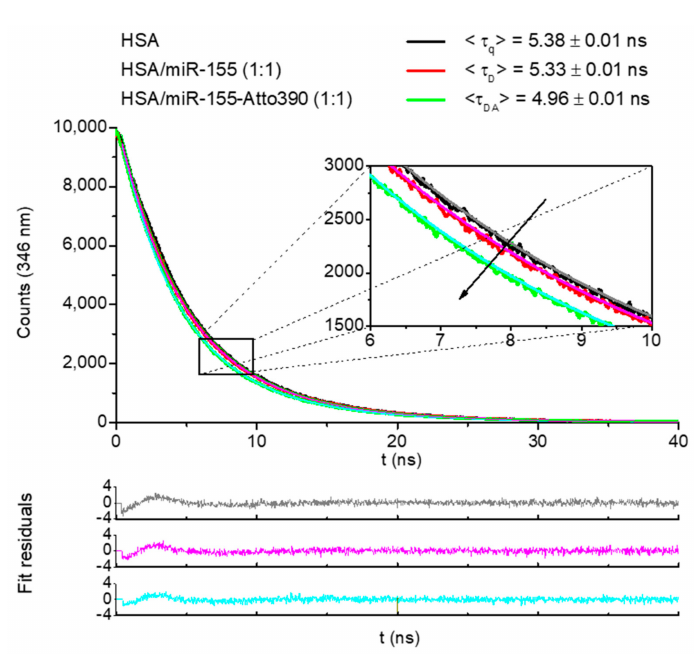
Figure 3. ( Top ): Time-resolved fluorescence decays of HSA, of the D (Donor) complex HSA/miR- 155 (1:1), and of the DA (Donor-Acceptor) complex HSA/miR-155–Atto390 (1:1), acquired using λ exc = 295 nm and λ em = 346 nm, at 298 K; c = 5 µ M in Tris-HCl buffer, pH 7.0. The respective average fluorescence lifetimes (< τ >), extracted by fitting the decays according to Equations (3) and (4), are reported. ( Bottom ): weighted fit